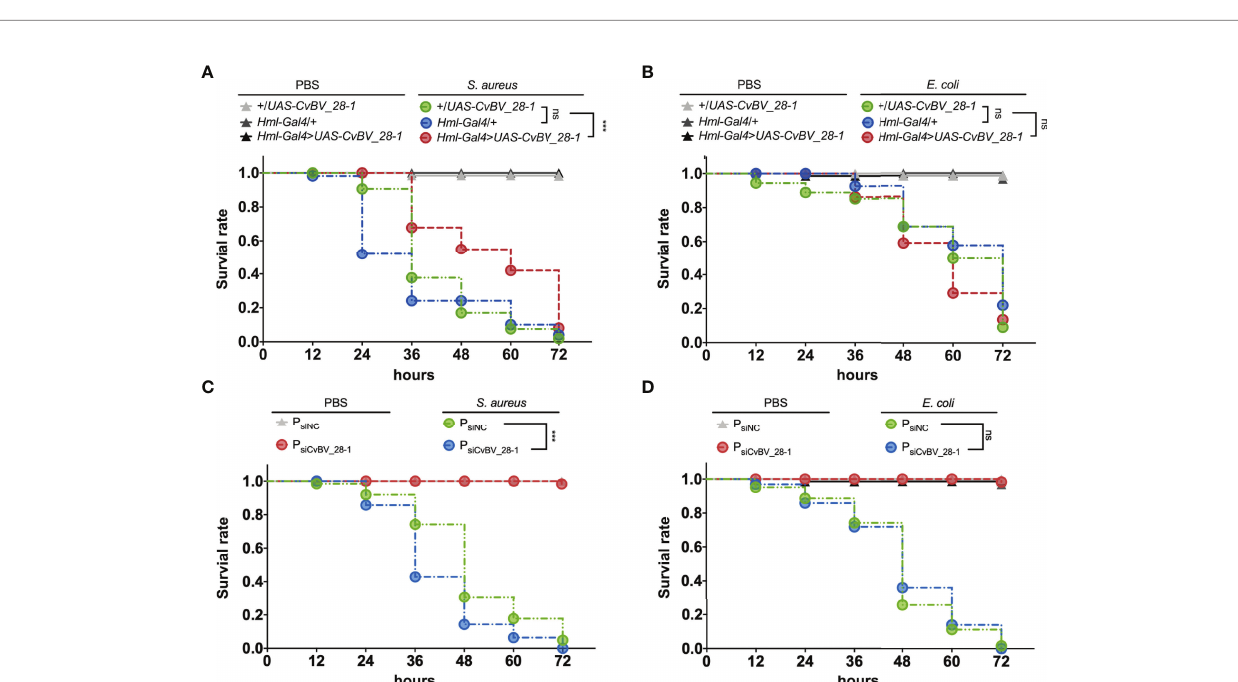
FIGURE 8 | Overexpression of CvBV_28-1 improves the survival rate after infection with S. aureus . (A) Survival rates of male Drosophila adults ectopically expressing CvBV_28-1 in hemocytes ( Hml-Gal4>UAS-CvBV_28-1 ), with Hml-GAL4 driver only ( Hml/+ ) and with UAS-CvBV_28-1 only ( +/UAS-CvBV_28-1 ) after injection of S. aureus . The fl ies injected with PBS served as controls. Experiments were performed with three independent replicates, and at least 20 fl ies were used for each replicate. Differences between groups were analyzed by the log-rank test (***p < 0.001; ns: not signi fi cant). (B) Survival rate of male Drosophila adults ectopically expressing CvBV_28-1 in hemocytes ( Hml-Gal4>UAS-CvBV_28-1 ), with the Hml-GAL4 driver only ( Hml/+ ) and with UAS-CvBV_28-1 only ( +/UAS- CvBV_28-1 ) after injection of E. coli . The fl ies injected with PBS served as controls. Experiments were performed with three independent replicates, and at least 20 fl ies were used for each replicate. Differences between groups were analyzed by the log-rank test (ns: not signi fi cant). (C) Survival rates of CvBV_28-1 knockdown in parasitized P. xylostella larvae (P siCvBV_28-1 ), with siNC-injected parasitized host larvae (P siNC ) after injection of S. aureus . The parasitized host larvae injected with PBS served as control. Experiments were performed with three independent replicates, and at least 20 P. xylostella larvae were used for each replicate. Differences between groups were analyzed by the log-rank test (***p < 0.001; ns: not signi fi cant). (D) Survival rates of CvBV_28-1 knockdown in parasitized P. xylostella larvae (P siCvBV_28-1 ), with siNC-injected parasitized host larvae (P siNC ) after injection of E. coli . The parasitized host larvae injected with PBS served as control. Experiments were performed with three independent replicates, and at least 20 P. xylostella larvae were used for each replicate. Differences between groups were analyzed by the log-rank test (ns: not signi fi